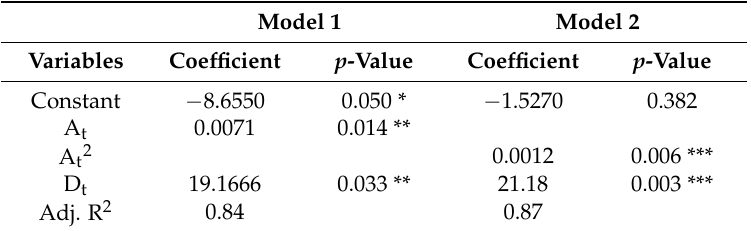
Table 3. Results from regression estimates of Models 1 and 2 with persons injured as the dependent variable, N = 14.